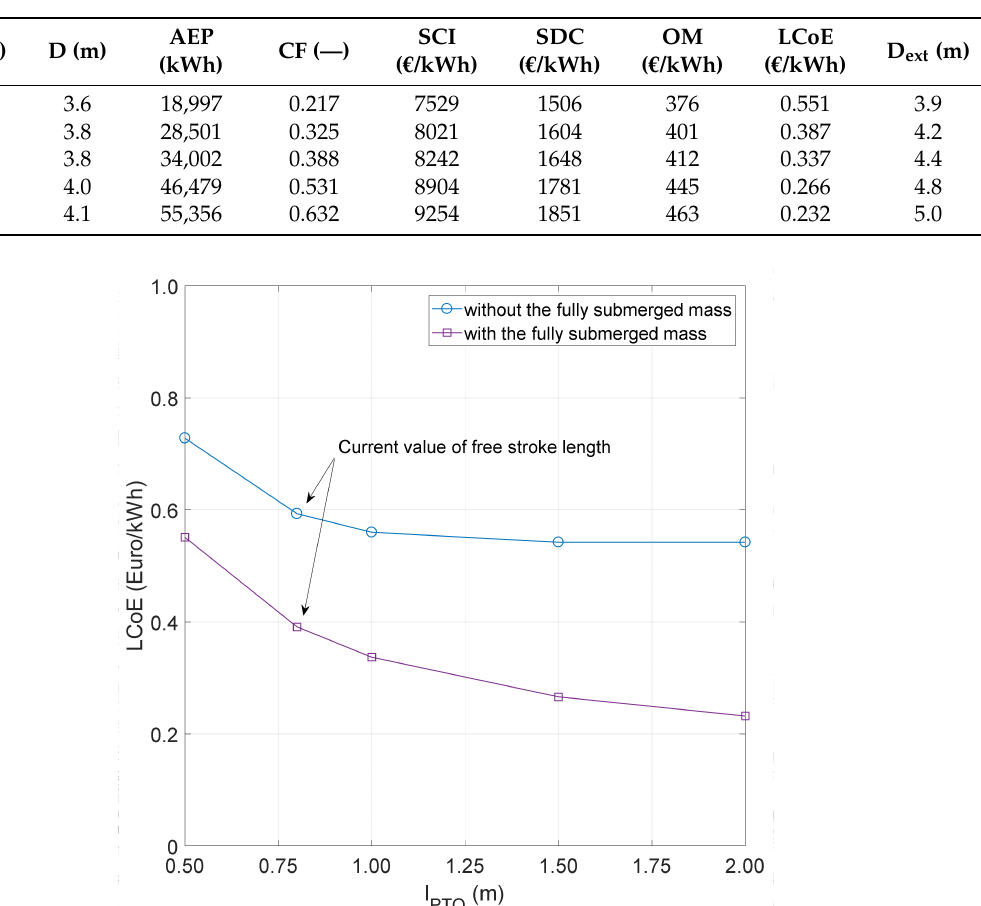
Figure 7. LCoE distribution versus the PTO free stroke length at